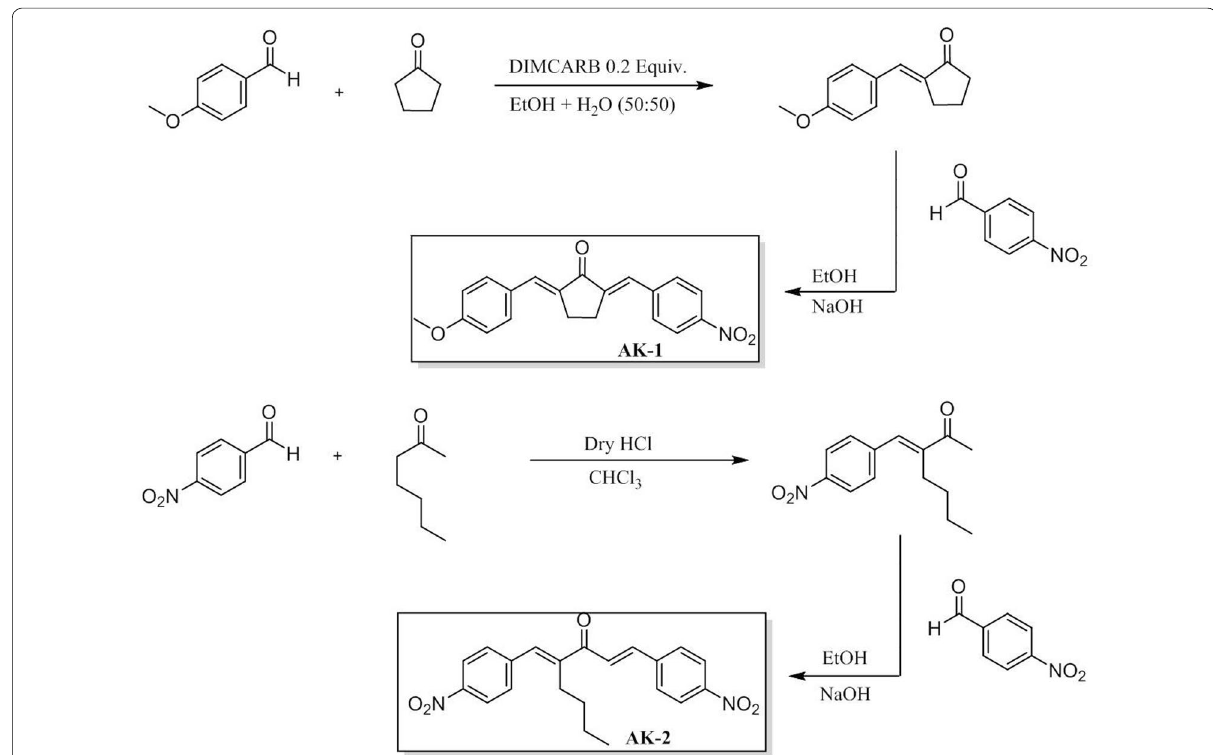
Fig. 1 Chemical structure and synthesis of (2 E ,5 E )‑2‑(4‑methoxybenzylidene)‑5‑(4‑nitrobenzylidene) cyclopentanone (AK‑1a) and (1 E ,4 E )‑4‑(4‑nitrob enzylidene)‑1‑(4‑nitrophenyl)oct‑1‑en‑3‑one